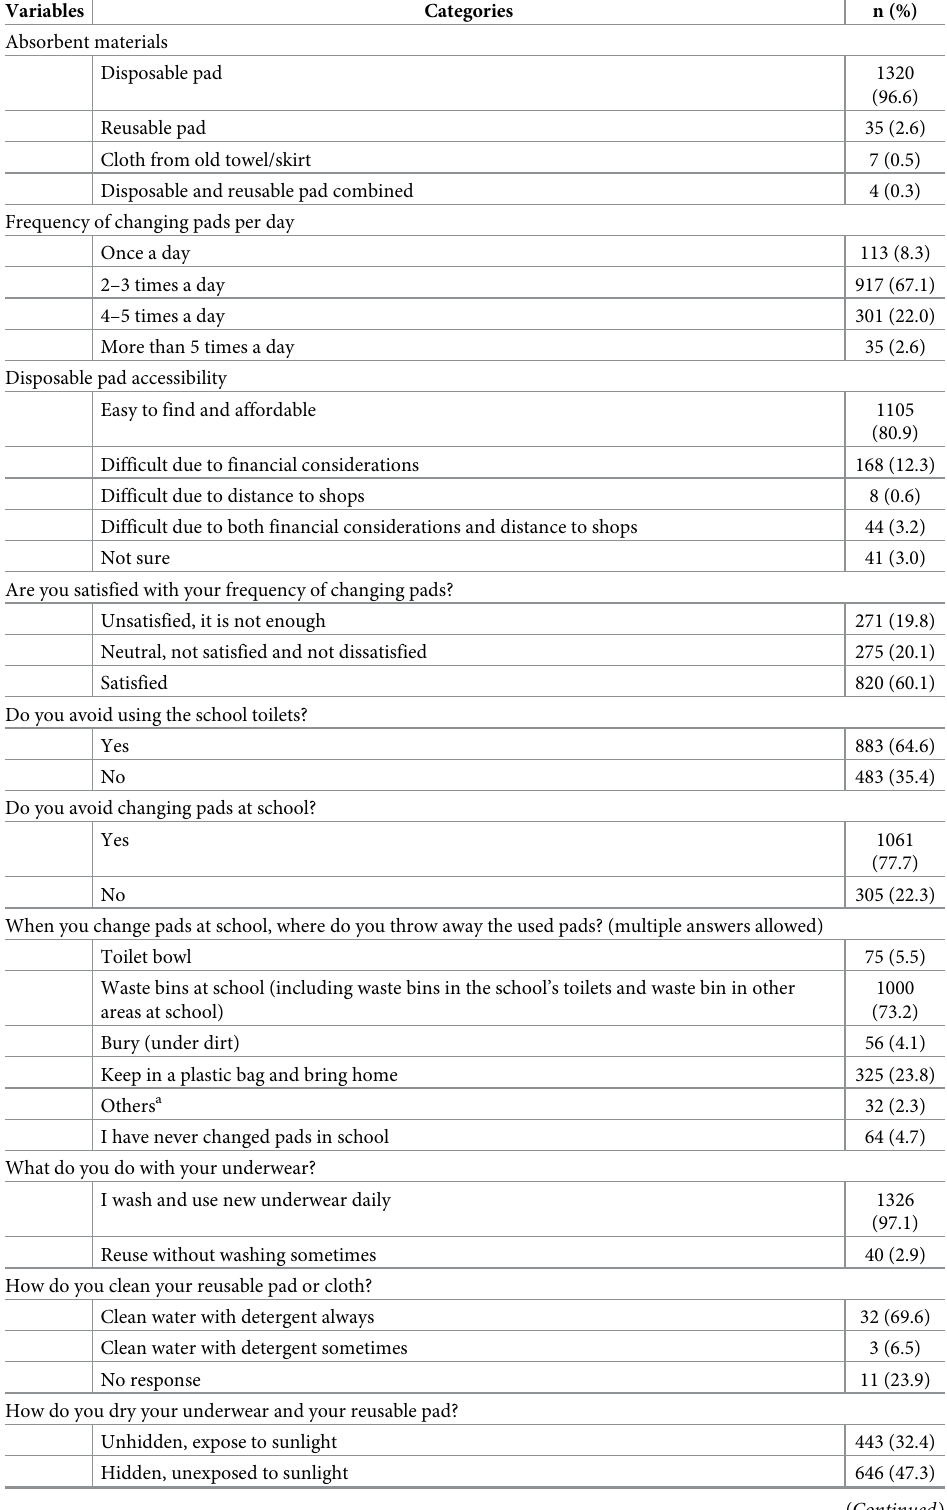
Table 4. Menstrual hygiene practices among girls in Luang Prabang Province (N =